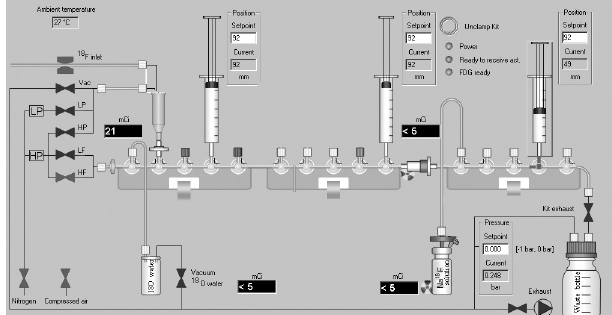
FIGURE 1 - Graphic of general purpose fluorination